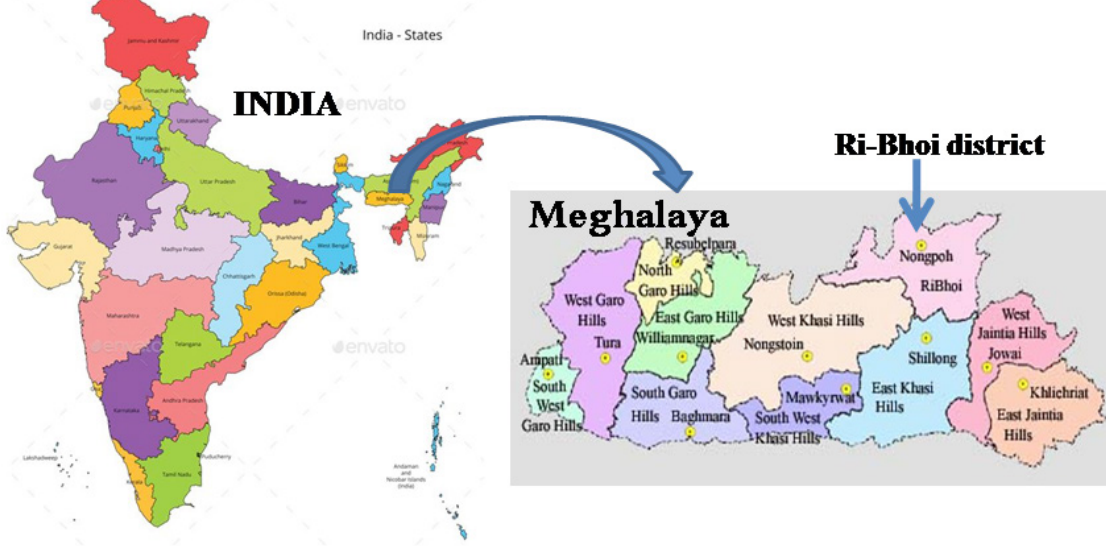
Fig 1. Maps showing the location of Ri-Bhoi district (collection/study site) of Meghalaya, India (maps not at scale).